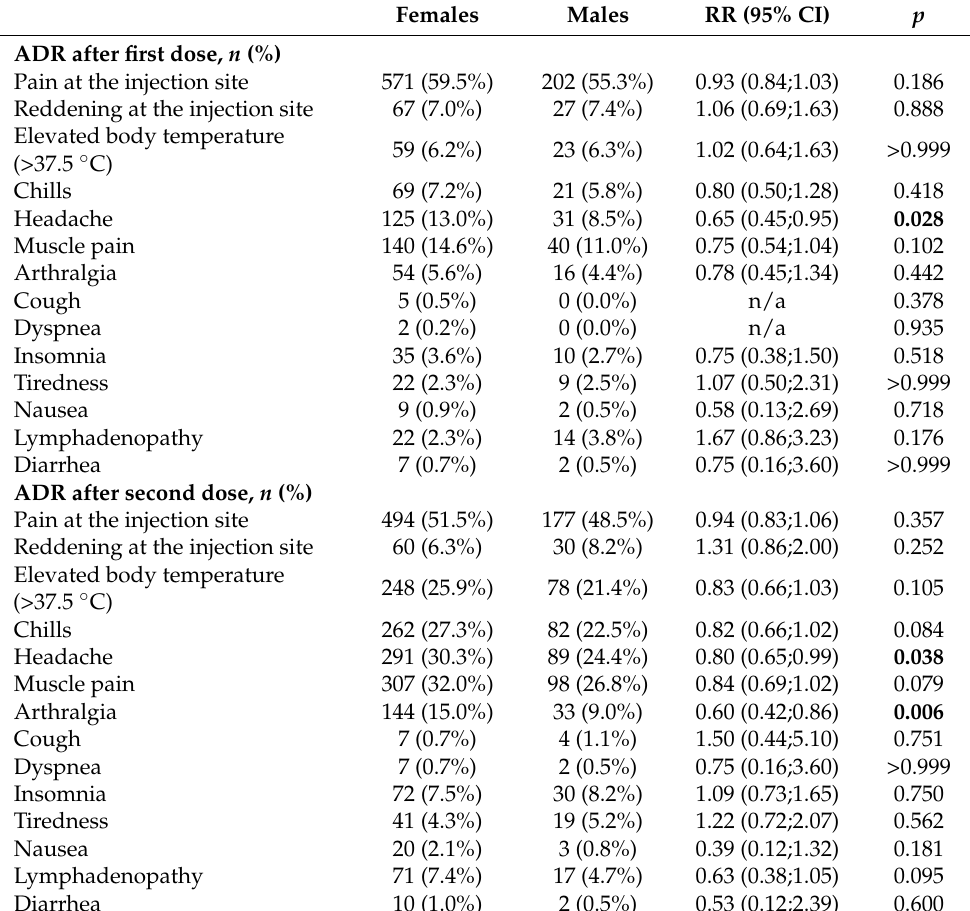
Table 3. Comparison of frequency of ADR between males and females for selected symptoms.